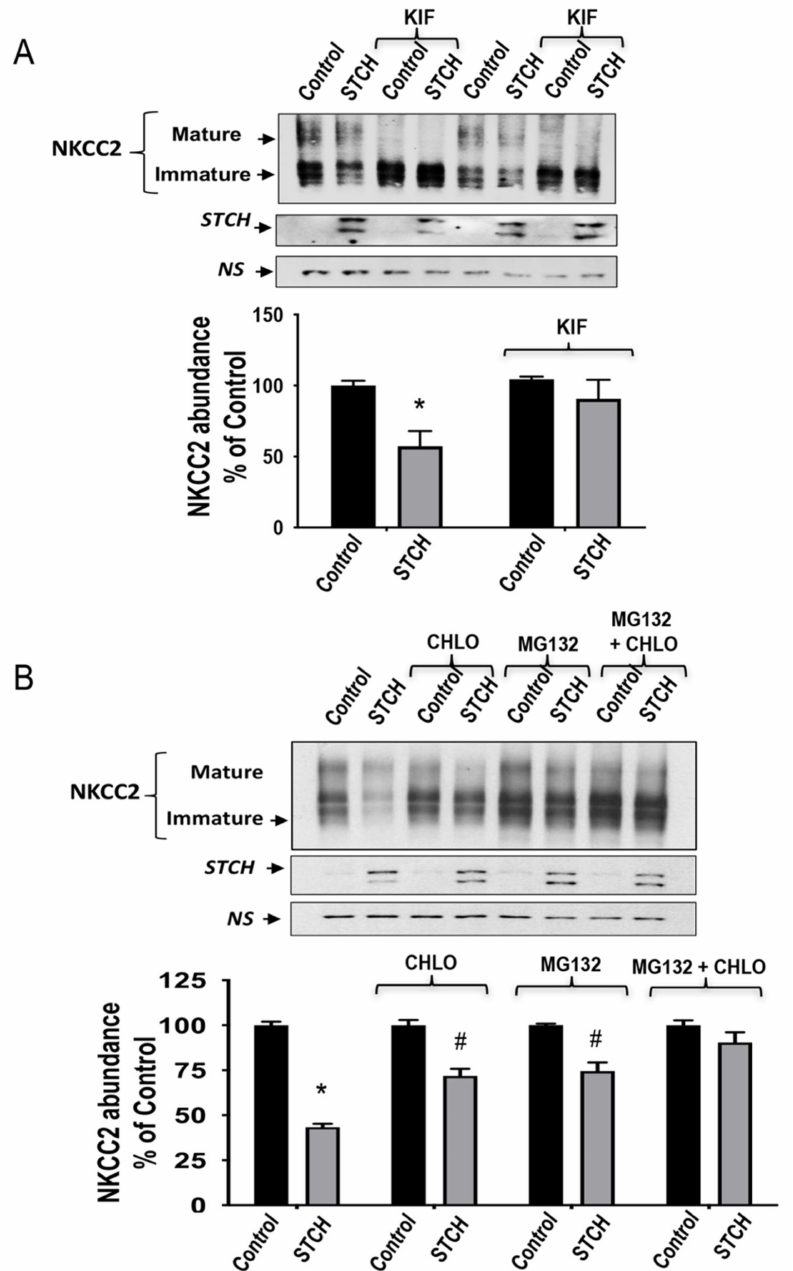
Figure 5. The ERAD of NKCC2 mediated by STCH involves both the proteasome and the lysosome. ( A ) Mannose trimming is required for STCH effect on NKCC2. OKP cells transiently transfected for with Myc-NKCC2 alone or with GFP-STCH, were treated with 25 µ M of kifunensine (KIF) or without for 12–14 h prior to cell lysis. The cell lysates were subjected to SDS-PAGE and immunoblotted with anti-Myc and anti-GFP antibodies. Bottom , densitometric analysis of NKCC2 bands from untreated and treated cells with kifumensine (KIF). Data are expressed as percentage of control ± SE. *, p < 0.02 versus control ( n = 3). ( B ) STCH decreases NKCC2 expression in a proteasome-dependent and lysosome dependent manner. 16 h post-transfection, HEK cells were treated with or without 2 µ m MG132 or 100 µ m chloroquine for 6 h prior to cell lysis. The cell lysates were subjected to immunoblotting with anti-Myc and anti-GFP antibodies. Bottom , densitometric analysis of NKCC2 bands from untreated and treated cells with MG132 or chloroquine (CHLO). Data are expressed as percentage of control ± S.E. #, p < 0.05 versus control ( n = 3). NS , a non-specific band illustrating the equal loading of protein